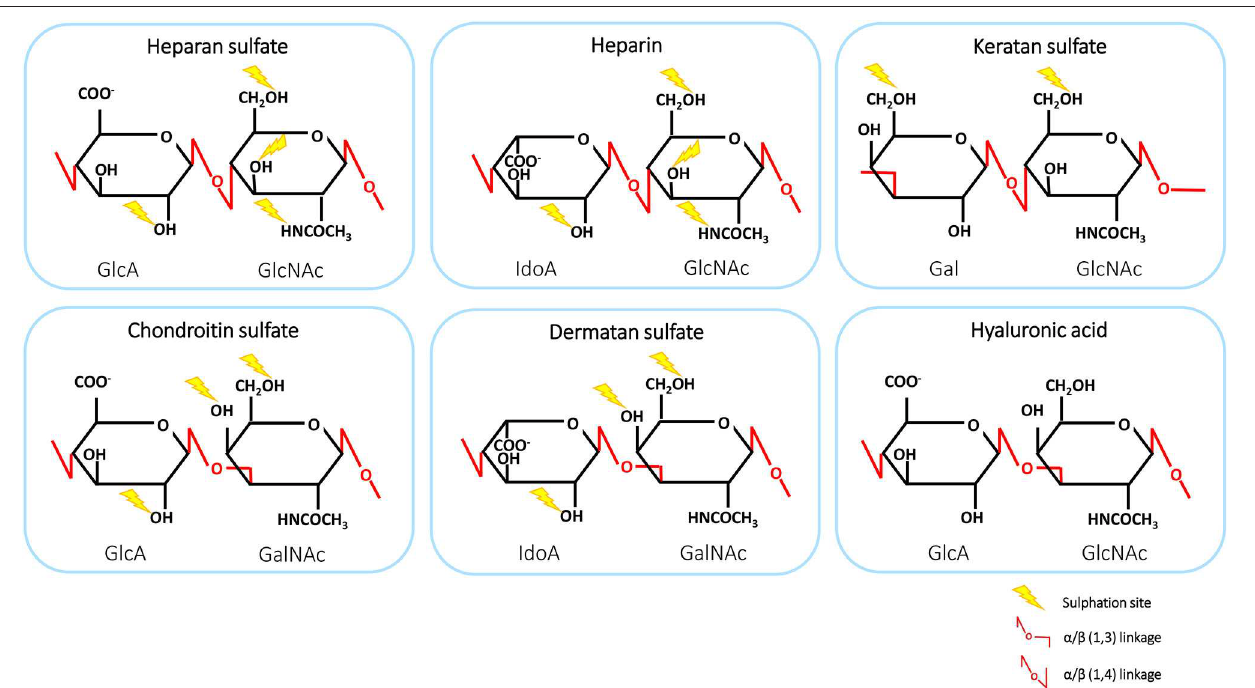
FIGURE 1 | The structure and disaccharide composition of glycosaminoglycans (GAGs). The backbone of GAGs consists of repeating disaccharide subunits, composed of uronic acid or galactose and an amino sugar. Linkages are shown in red and sites of sulphation are indicated by yellow lightning bolts. GlcA, D-glucuronic acid; GlcNAc, N-acetyl-D-glucosamine; GalNAc, N-acetyl-D-galactosamine; Gal, D-galactose; IdoA, L-iduronic acid.